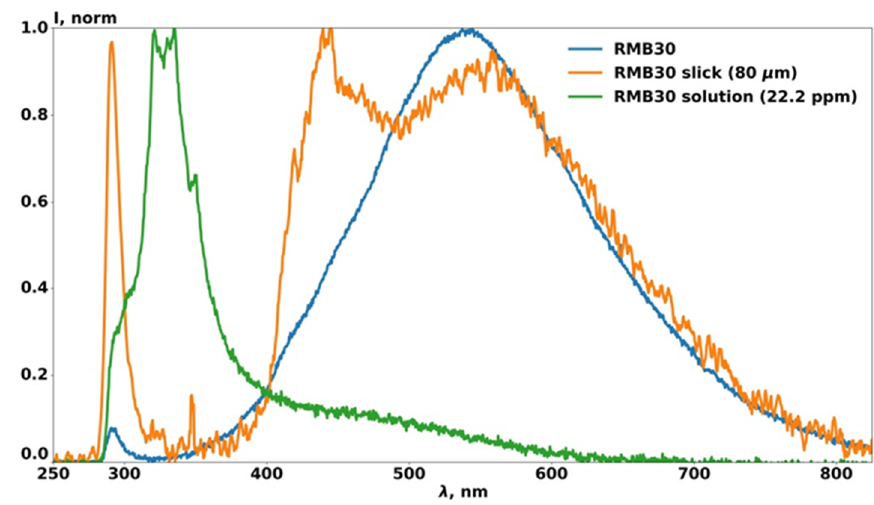
Figure 4. LIF spectra of the heavy RMB 30 marine fuel depending on its state.